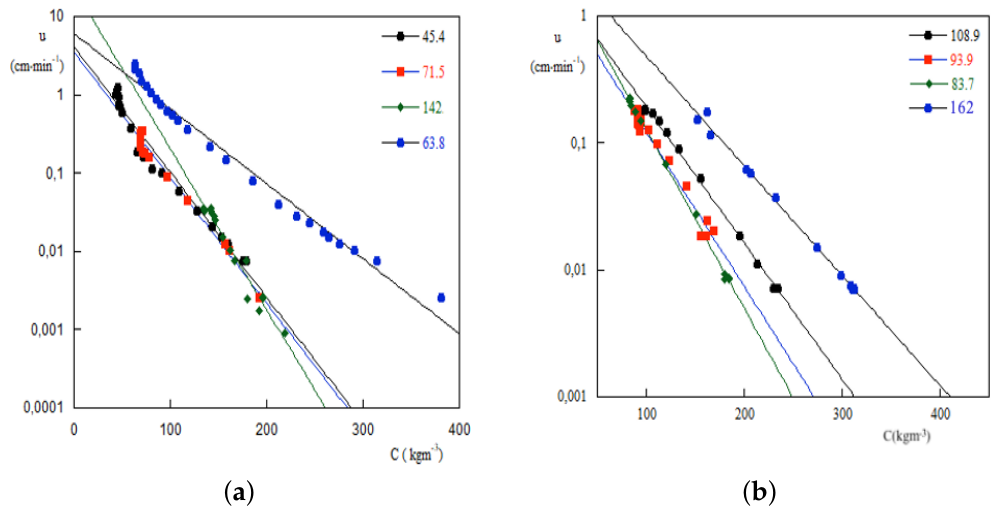
Figure 6. Sedimentation rates. ( a ) Normalized sedimentation profiles of clay material from Occhito reservoir. The numbers indicate concentrations (kg m − 3 ) of the solids. ( b ) Sedimentation rates computed for dispersion clays taken from Occhito’s reservoir and not mixed with flocculant solution. The numbers represent the concentration (kg m − 3 ) of the solids.